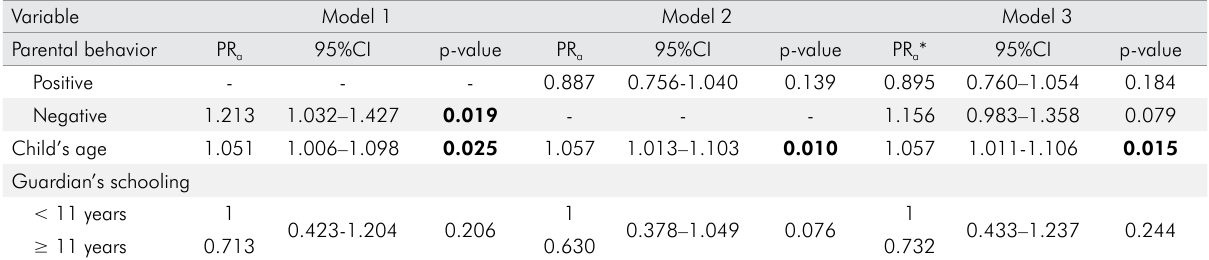
Table 3. Multiple poisson model with robust variance for untreated dental caries in preschool children. São José dos Pinhais, PR, Brazil (n =